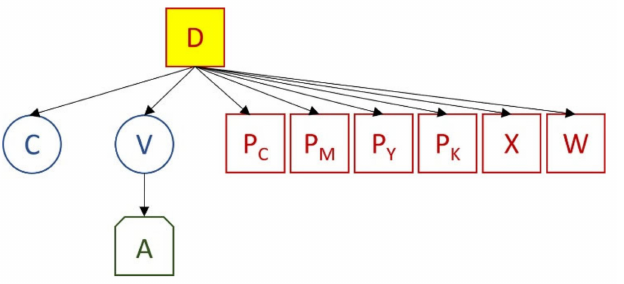
Figure 4. Task decomposition diagram for the paint-mixing robot agent showing the Dilute Paint task (highlighted) and its component task dependencies.